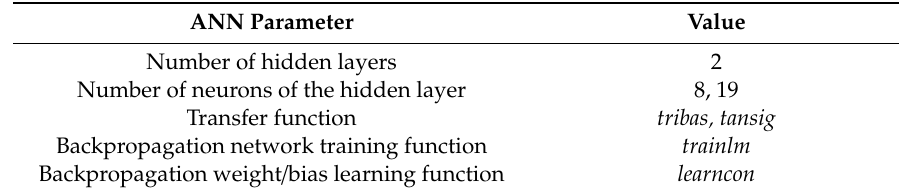
Table 3. Parameter values in the artificial neural network (ANN) that are used in hybrid ANN-CA architecture in order to select the most e ff ective (discriminant) features